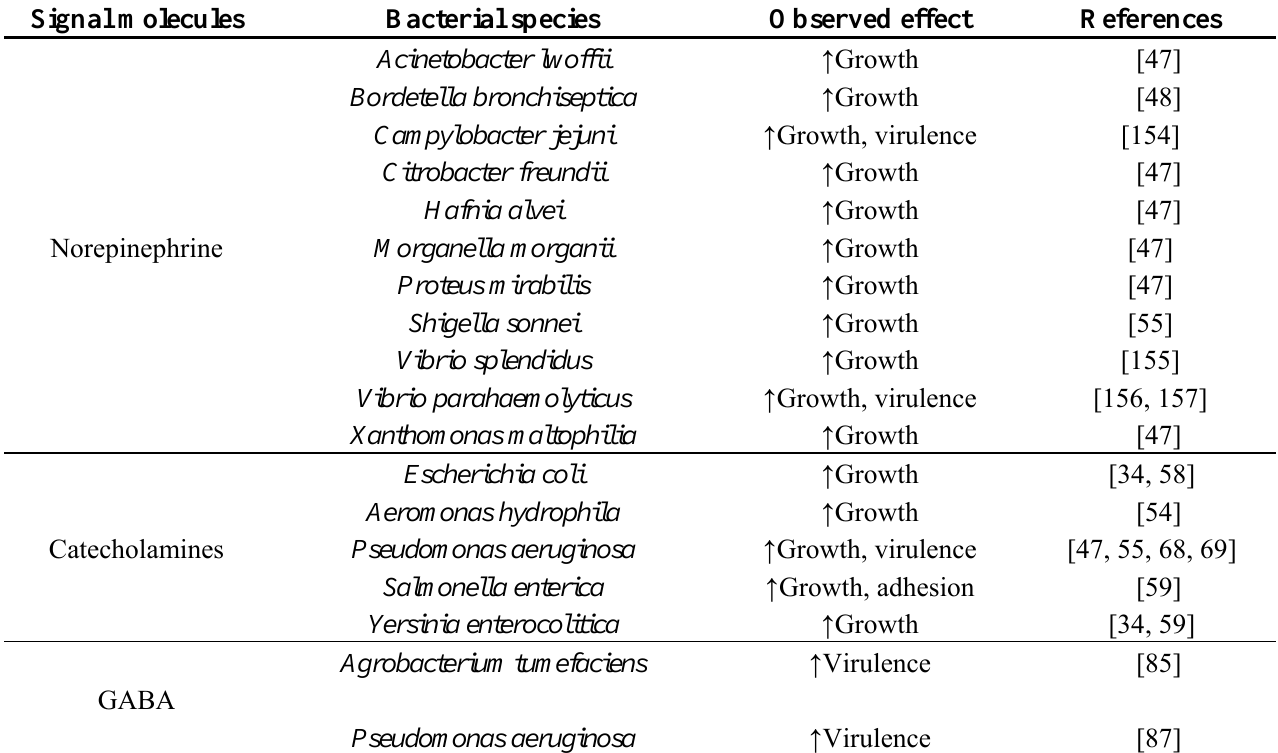
Table 1. Neurotransmitters and